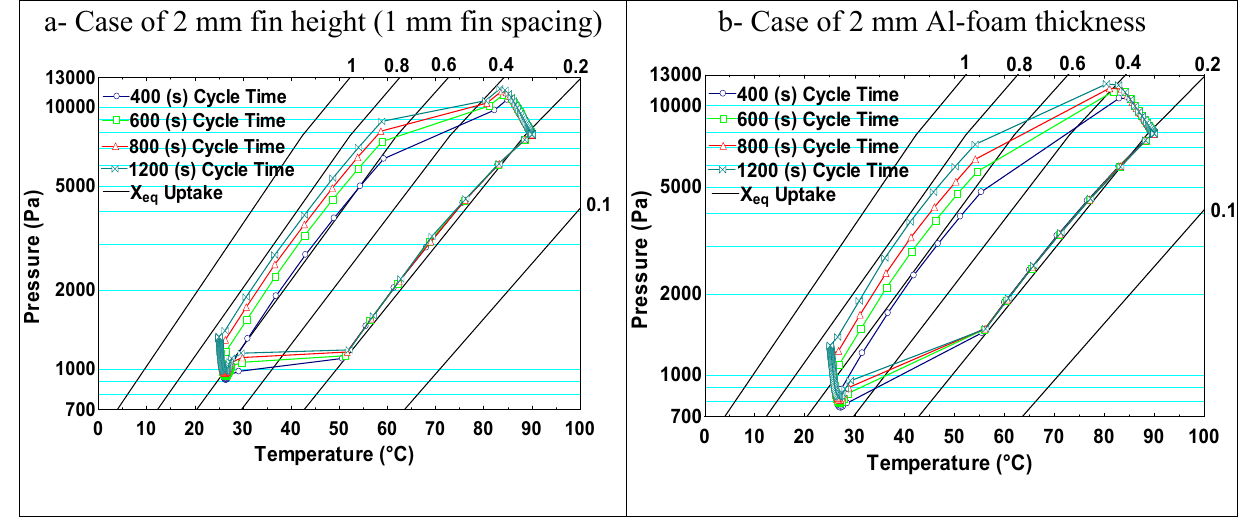
Figure 5. The T ‐ P ‐ X diagram for the bed of both systems during the cyclic steady state at different cycle times and 2 mm fin height/foam thickness. ( a ) Finned ‐ tube based bed, ( b ) Al ‐ foam based bed.